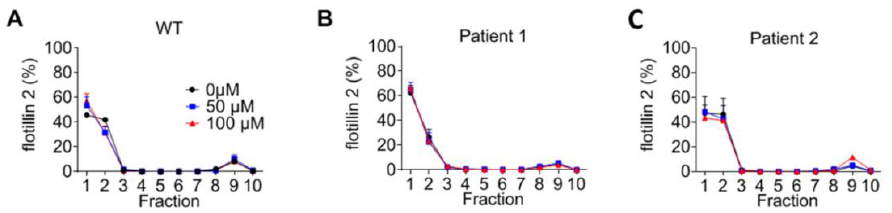
Figure 7. Flotillin-2 distribution in 10 fractions isolated from a sucrose density gradient. Fibroblasts